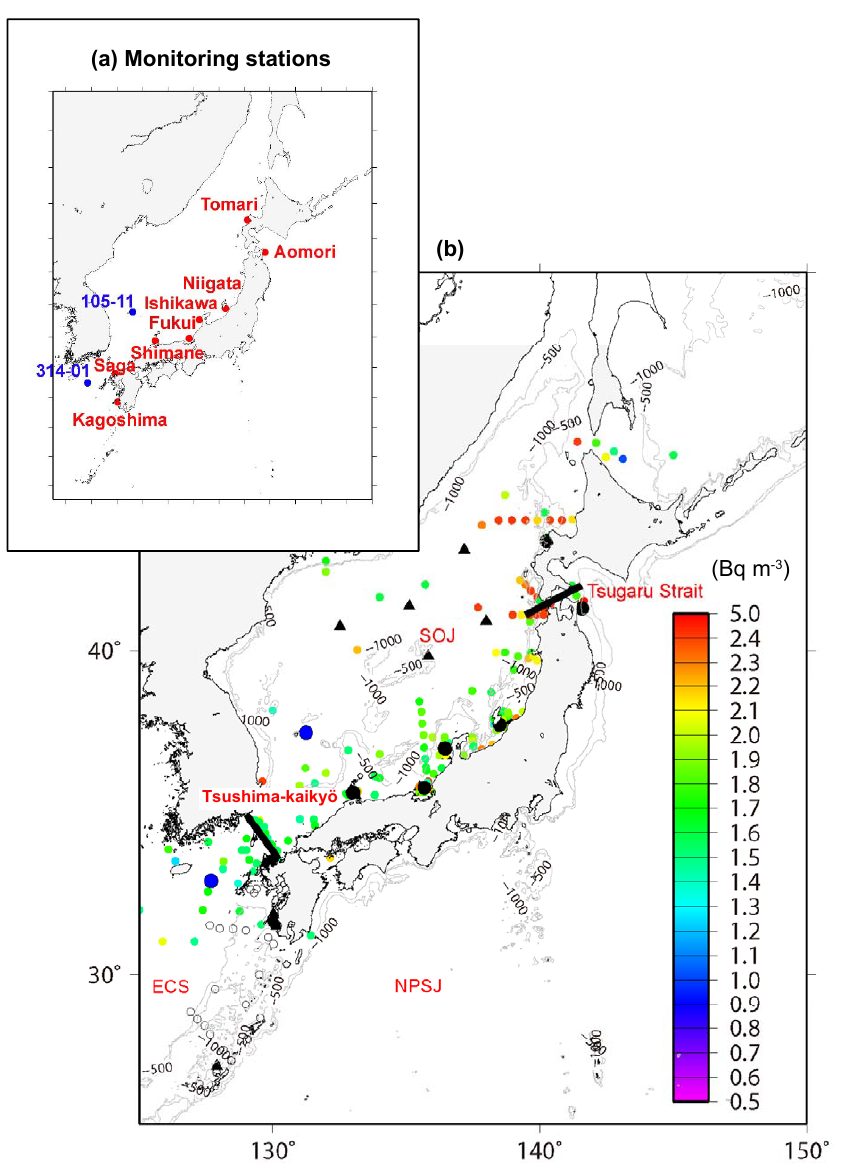
Figure 1. Location of the sampling points after the FNPP1 accident. Large black circles are sites monitored by the Japanese government. Blue circles are sites monitored by the Korean government. Black triangles are sites with measured vertical profiles. The colours of other circles correspond to the 137 Cs activity concentrations measured in 2011. Open circles are sites measured after 2012. The area around Japan was divided into three regions: the SOJ, ECS and NPSJ (<141.5 ◦ E). The locations of monitoring stations are also plotted in (a) .